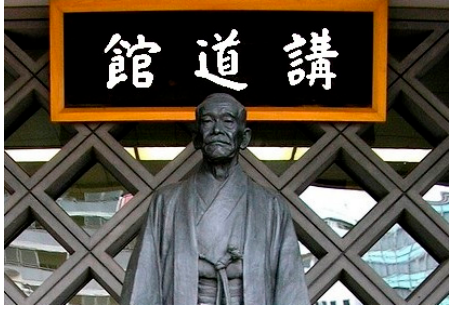
Figure 1. Statue of Jigoro Kano at the entrance of the Kodokan (Tokyo, Japan).